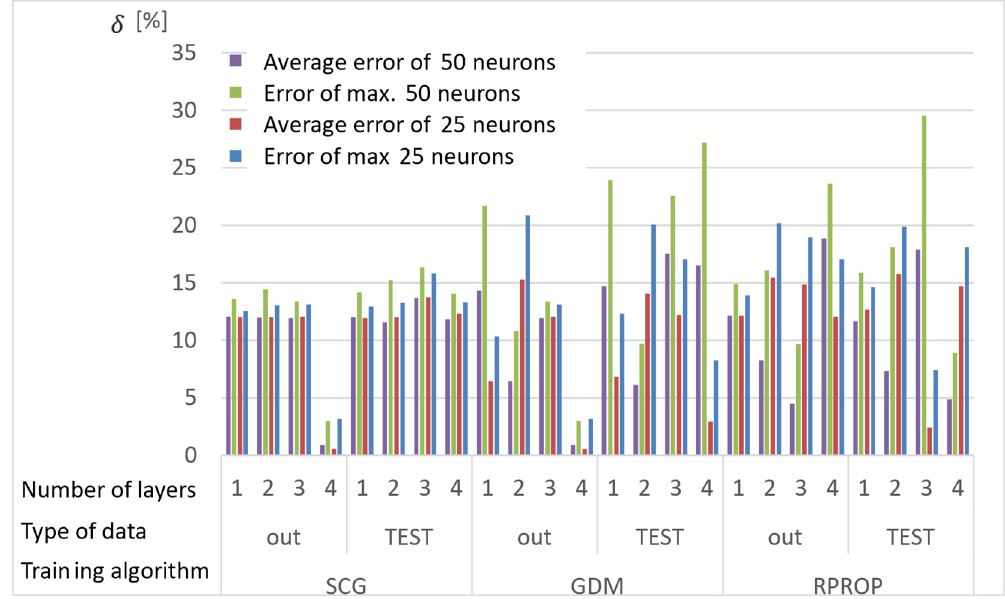
Figure 7. Maximum and average relative error for selected structures of neural networks and training algorithms after the first training cycle.